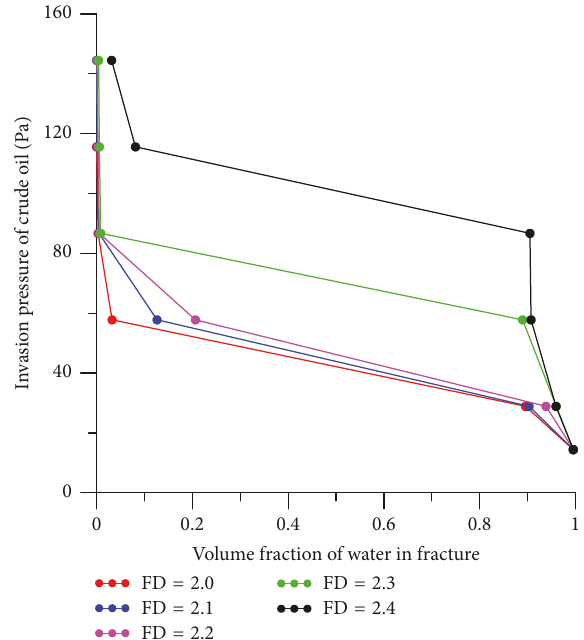
Figure 10: Relationship curves of the invasion pressure of crude oil and the volume fraction of water in the fracture for different roughness at time